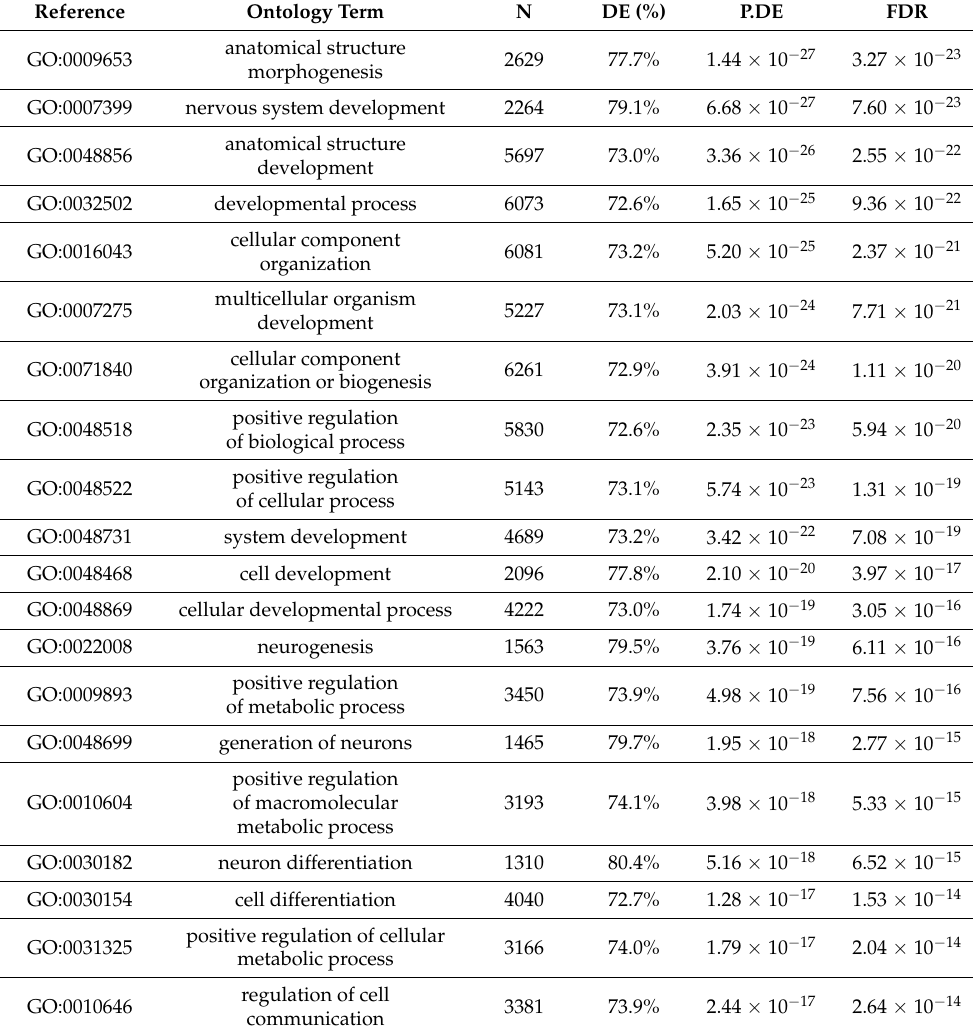
Table 4. Top 20 gene ontologies (biological processes) based on the highest significance (FDR) between high-grade (>1) and low-grade